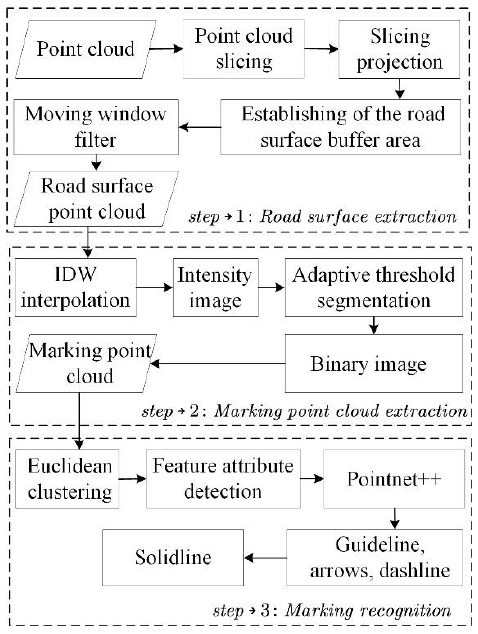
Figure 1. Flowchart of proposed method